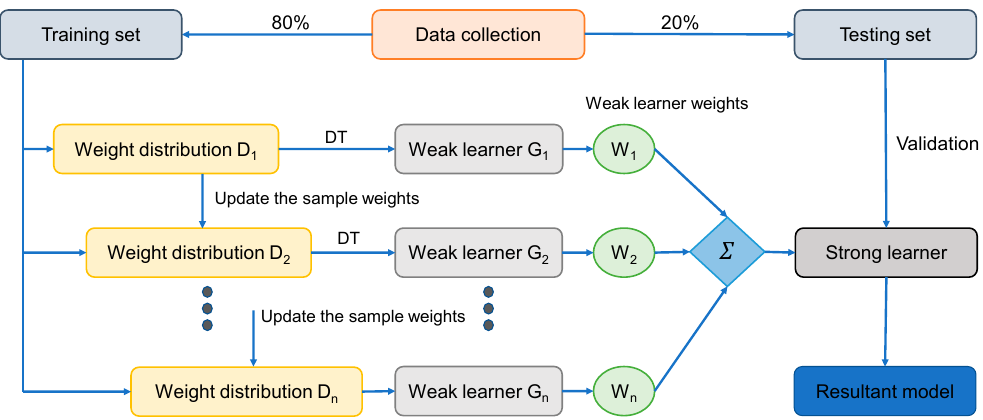
Figure 6. Sequence of AdaBoost regressor modeling process [69].